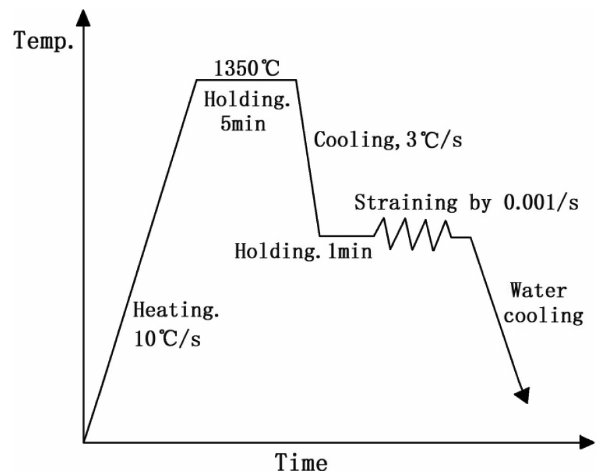
Fig. 1: Thermal schedule used for investigation of hot ductility of Ti-bearing